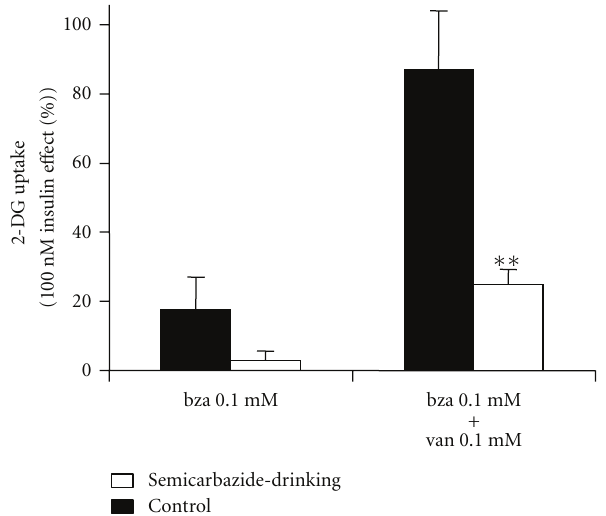
Figure 4: Influence of 8-week oral administration of semicarbazide on benzylamine-induced glucose transport in mouse adipocytes. Visceral adipocytes were incubated with 0.1 mM benzylamine alone (bza) or combined with 0.1 mM vanadate (bza + van) for 2- DG uptake assay. Data are expressed as percentage of response to 100 nM insulin, which maximally stimulated basal uptake by 3.3 ± 0.4-fold in control (black columns) and by 4.8 ± 0.8-fold in semicarbazide-drinking mice (open columns). Mean ± SEM of 8 determinations. Di ff erent from control at ∗∗ P < .